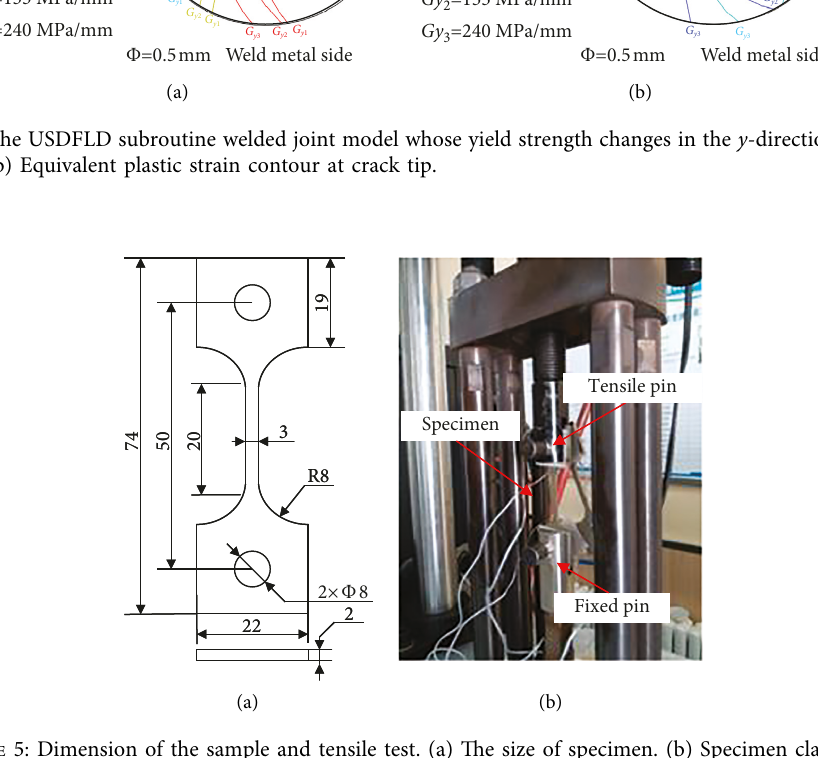
Figure 5: Dimension of the sample and tensile test. (a) The size of specimen. (b) Specimen